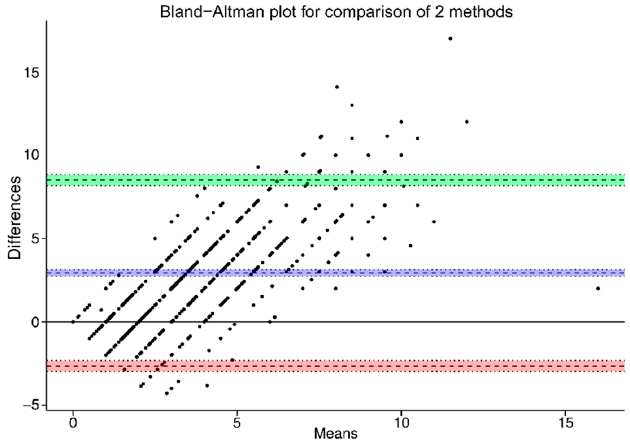
Figure 3. Bland–Altman plot of Q9a, agreement between number/slices of bread reported during the DH and the FFQ (n = 848). The purple/blue line represents the mean difference between the two methods, and the red and green lines represents the limits of agreements corresponding to ±1.96 SD (lower agreement: − 2.65 slices/day, upper agreement: 8.51 slices/day).